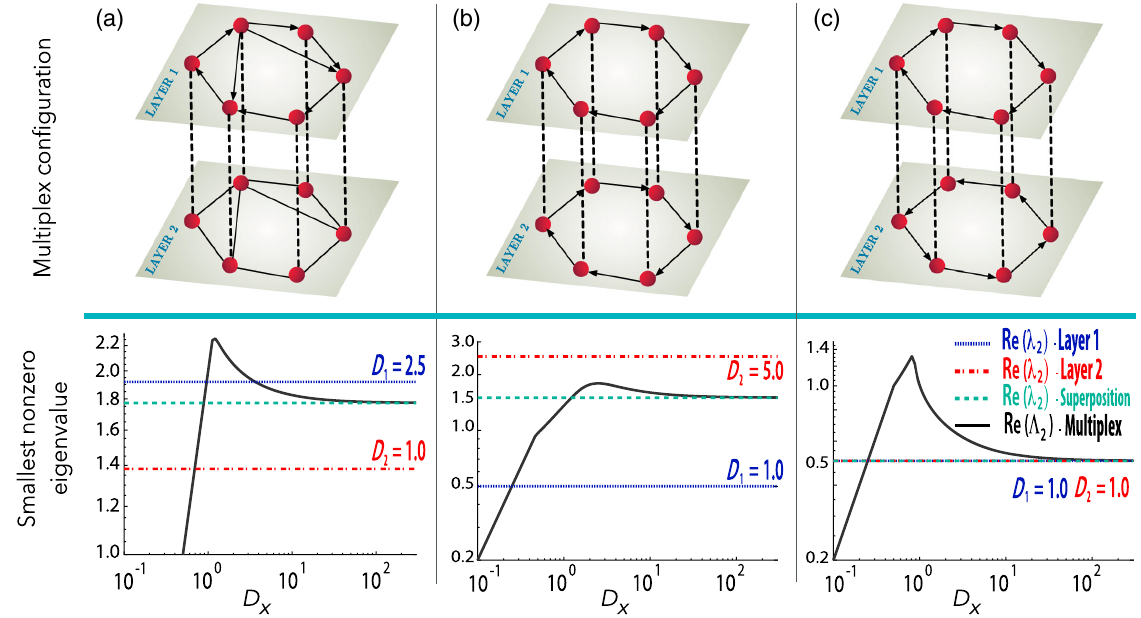
FIG. 1. The top panels depict the three synthetic multiplex networks with two coupled layers discussed in the text: (a) corresponds to Multiplex 1, (b) to the Multiplex 2 configuration, and (c) to the Multiplex 3 architecture. Bottom panels show the behavior of the smallest (in terms of its real part) nonzero eigenvalue Re ð Λ 2 Þ of the supra-Laplacian L out as a function of interlayer coupling D X